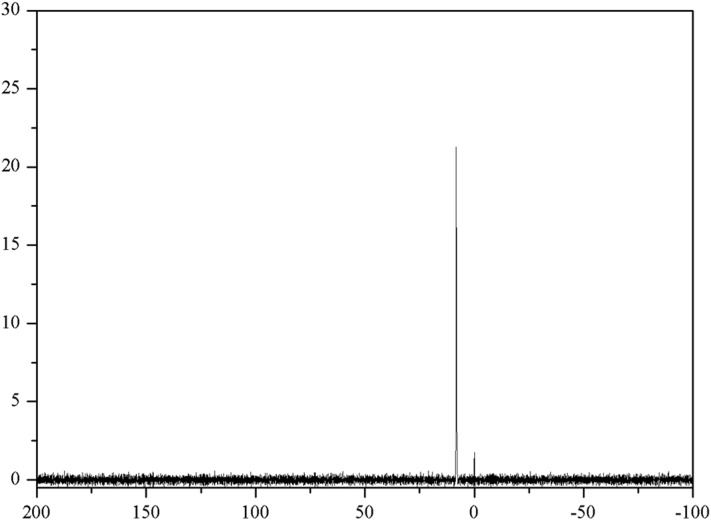

31P NMR spectroscopy of DMAB(P)-Ch.